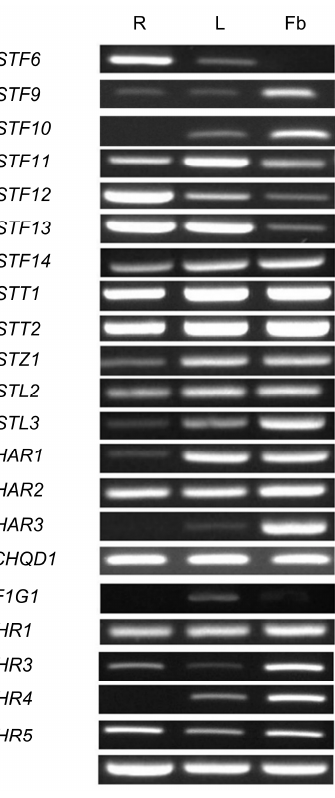
Figure 4. BoGST mRNAs showed distinct expression patterns in B. oleracea organs (R—Root, L—Leaf, and Fb—Flower bud). Transcripts specific for each GST genes amplified by reverse transcription-PCR, visualized using 1.5% agarose gel.